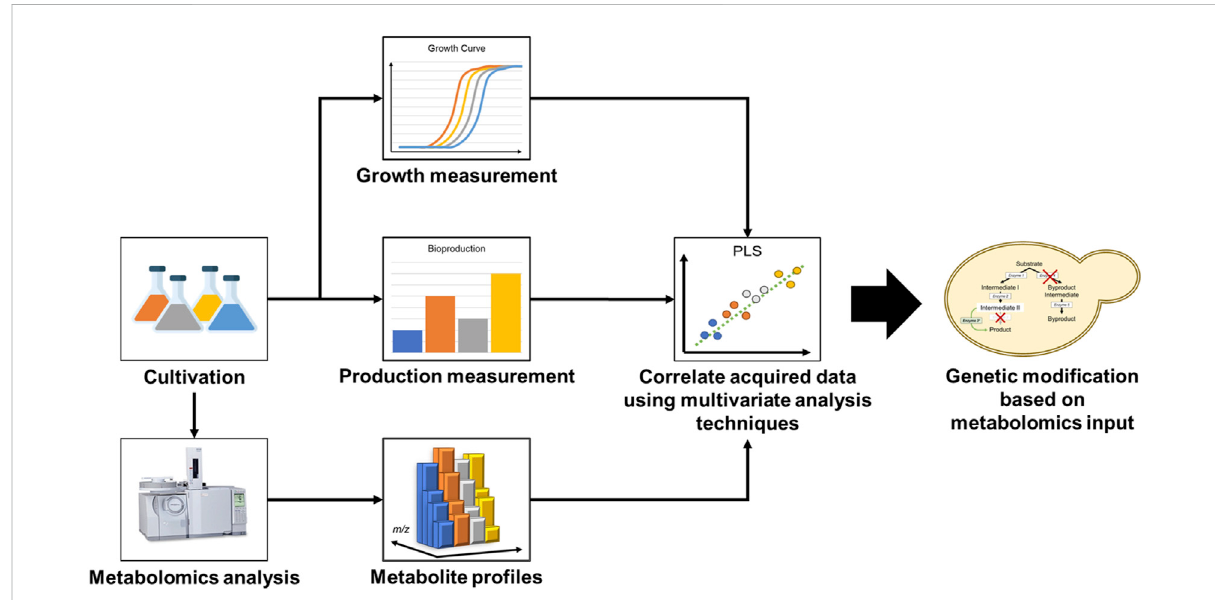
FIGURE 1 Metabolomics-driven strain improvement work fl